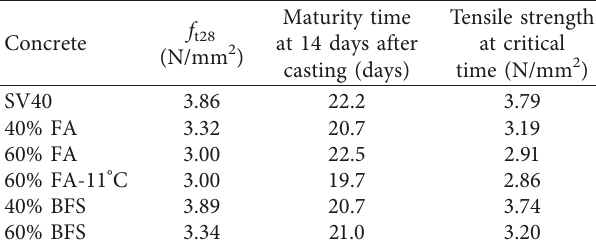
Figure 12: Calculated temperature (a) and stress (b) developments of 60% BFS concrete. Table 8: Tensile strength at 14 days after casting.